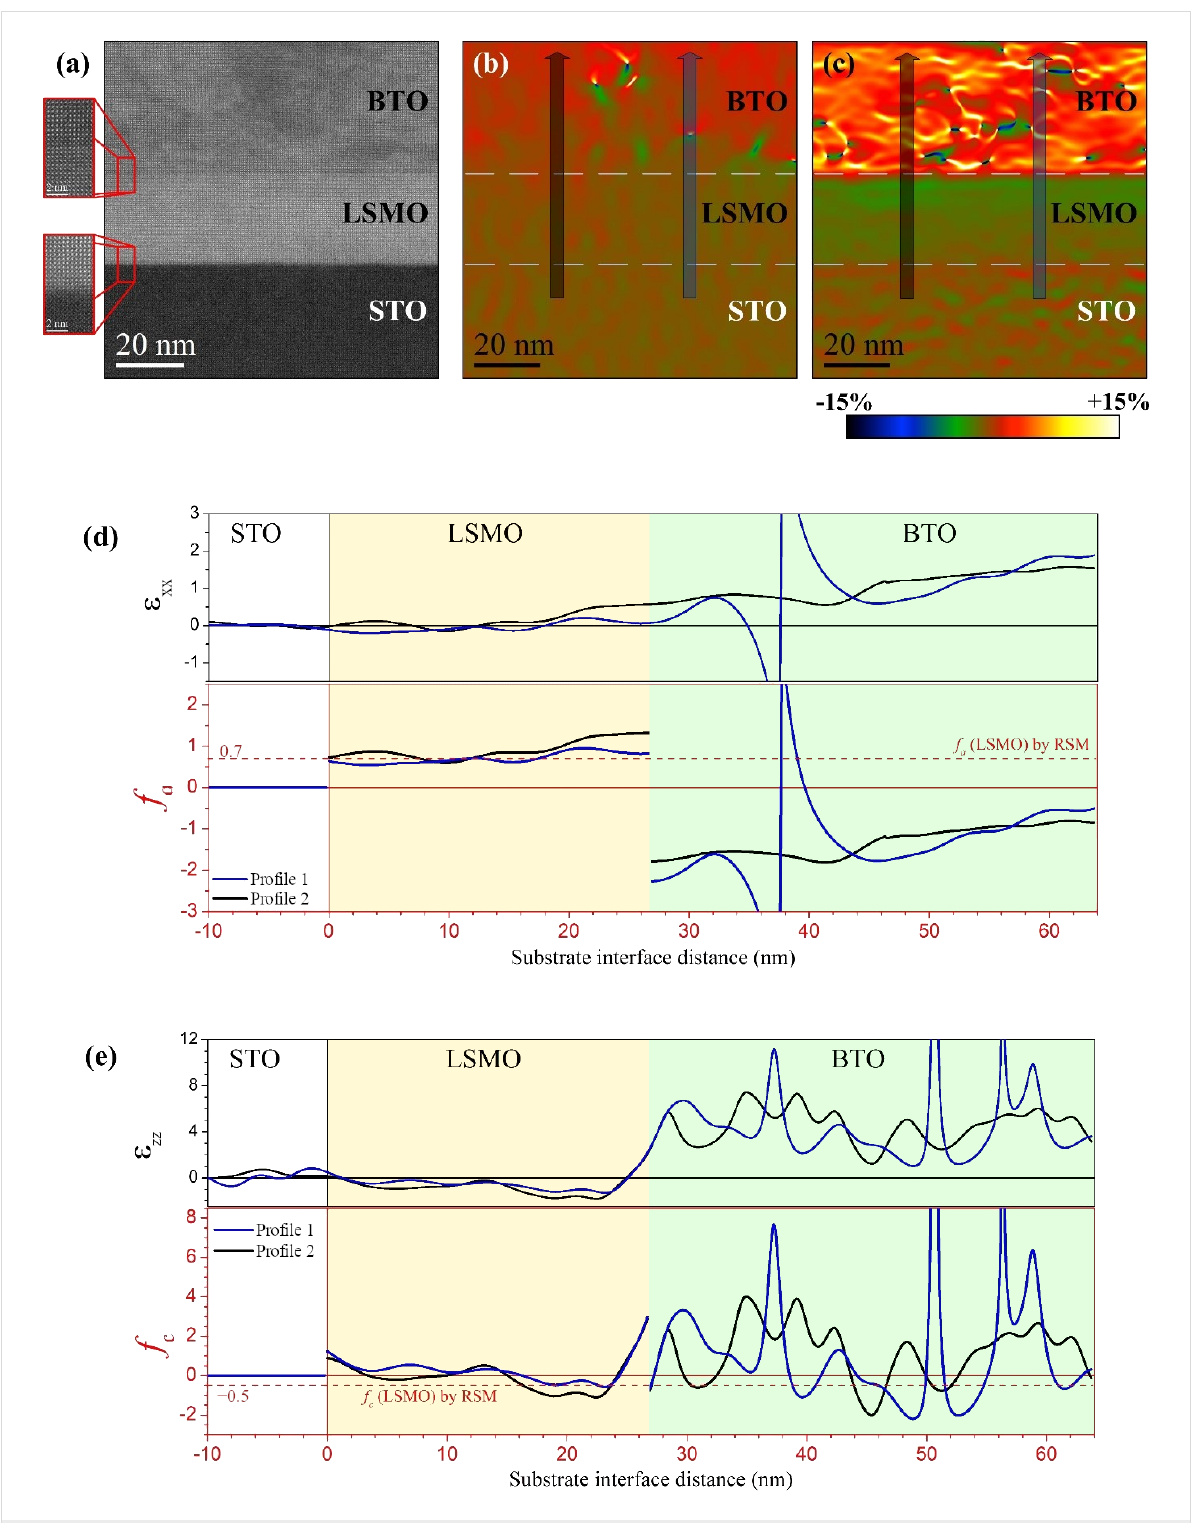
Figure 5: (a) Cross-section HAADF-STEM image for a BTO/LSMO bilayer grown on STO. Insets correspond to high-magnification HAADF-STEM images recorded close to the BTO/LSMO and LSMO/STO interfaces, top and bottom, respectively. Strain maps for the (b) in-plane, ε xx , and (c) out- of-plane, ε zz , lattice parameters obtained by applying GPA to (a). Dotted white lines mark the interfaces. (d) In-plane [ ε xx and f a ] and (e) out-of-plane [ ε zz and f c ] vertical strain profiles extracted from the GPA maps. Black and blue arrows mark the profile direction and area. Profile 1 (blue line) passes through a misfit BTO dislocation, and Profile 2 (black line) passes through a dislocation-free